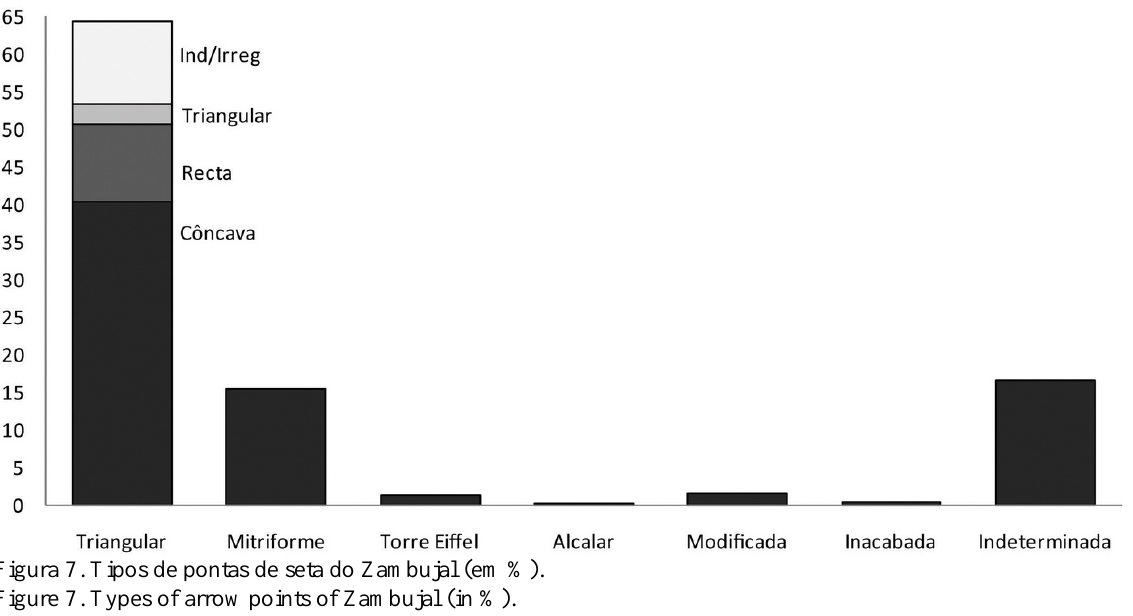
Figura 7. Tipos de pontas de seta do Zambujal (em %). Figure 7. Types of arrow points of Zambujal (in